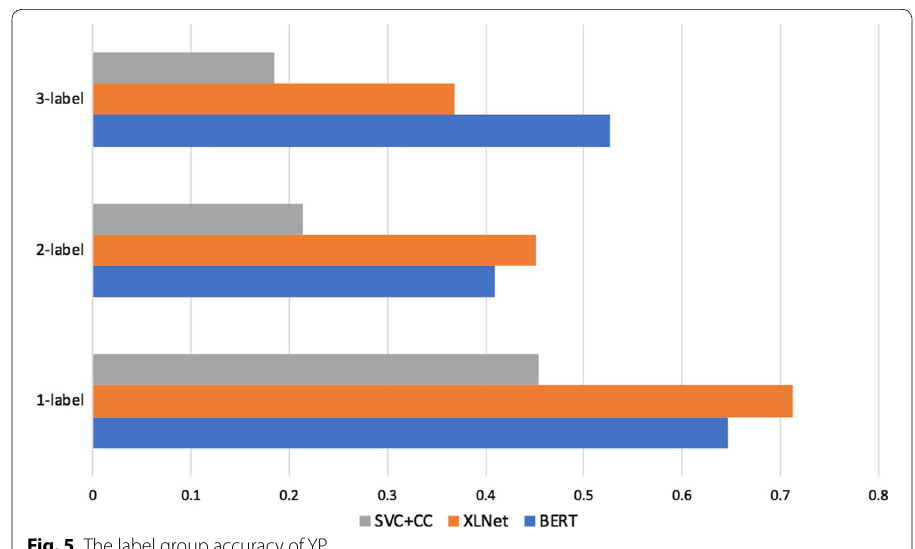
Fig. 5 The label group accuracy of